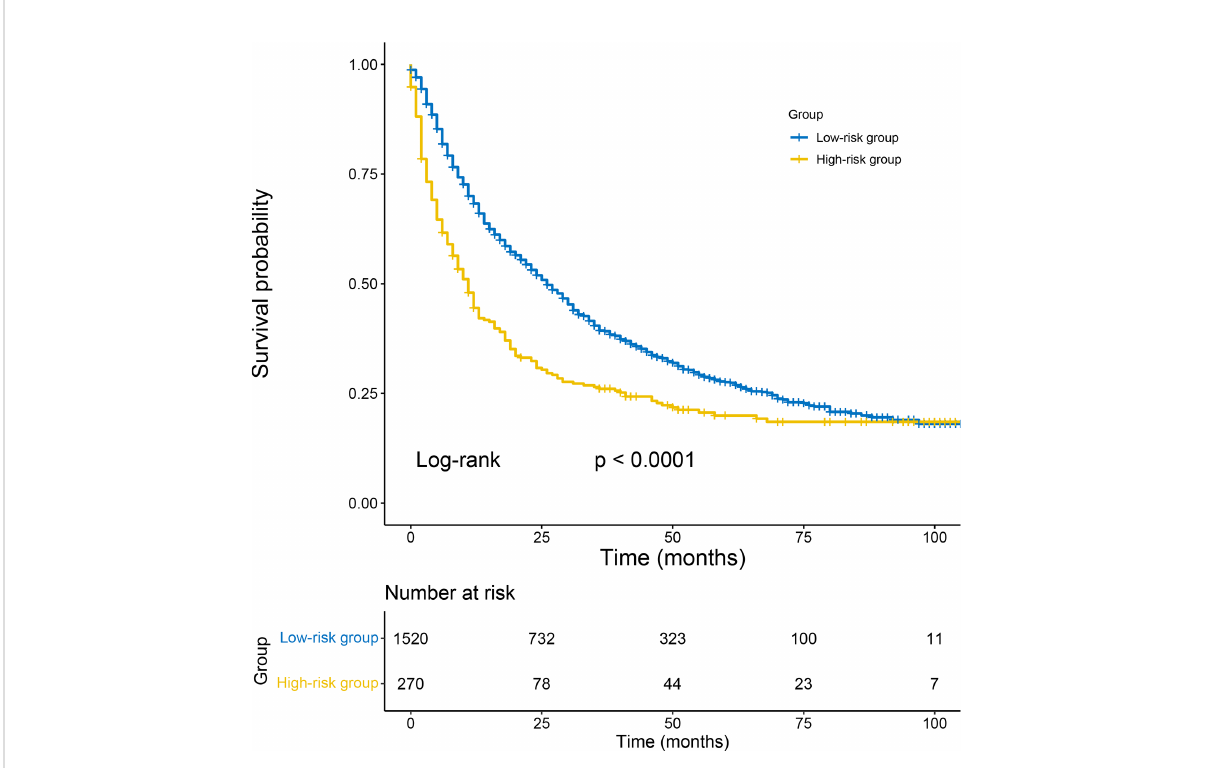
FIGURE 7 Kaplan – Meier survival analyses to test the risk strati fi cation system within the total cohort. The blue line represents low-risk group, and the yellow line represents high-risk group. Low-risk group (score ≤ 257); high-risk group (score